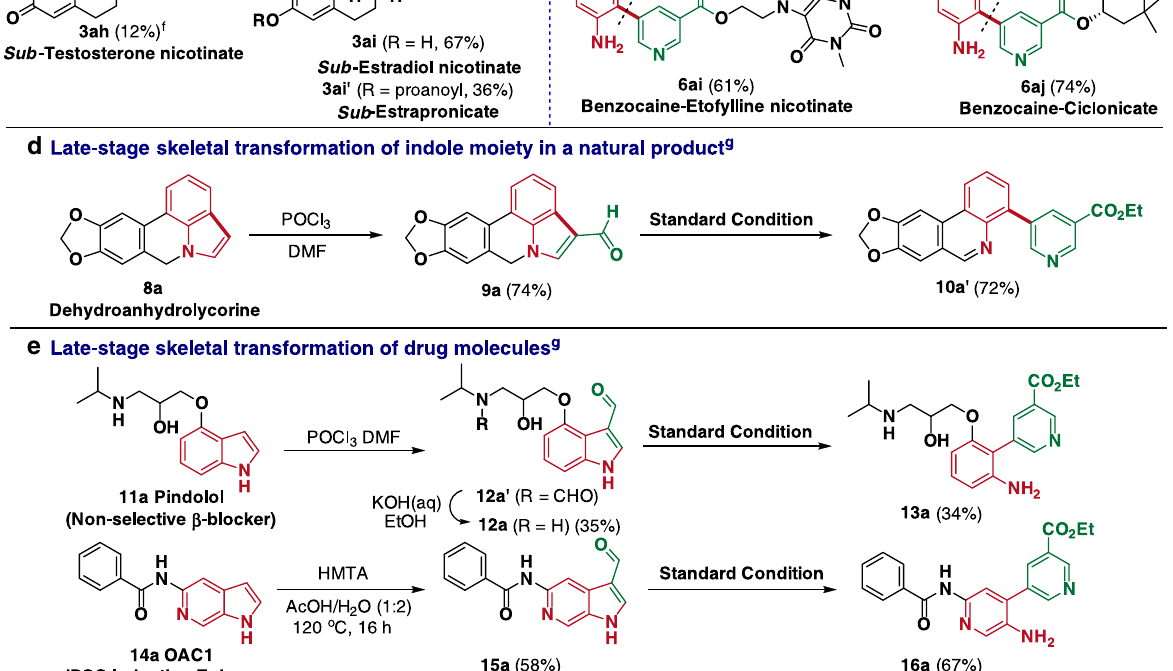
Fig. 4 Extending the scope of the reaction towards the synthesis of substituted bioactive niacinates and anilinic drugs. a Scope of the reaction for the synthesis of meta- substituted bioactive nicotinates. b Scope of the reaction for the synthesis of ortho- substituted bioactive N- protected or free anilinic drugs. c A representative example of conjugates containing bioactive nicotinates and anilinic drugs via C – C bond. d , e Extension of the scope of our synthetic strategy for late-stage skeletal transformation of (aza)indole moiety in natural products and pharmaceuticals. See Supplementary Information for reaction condition and further details (a – g)